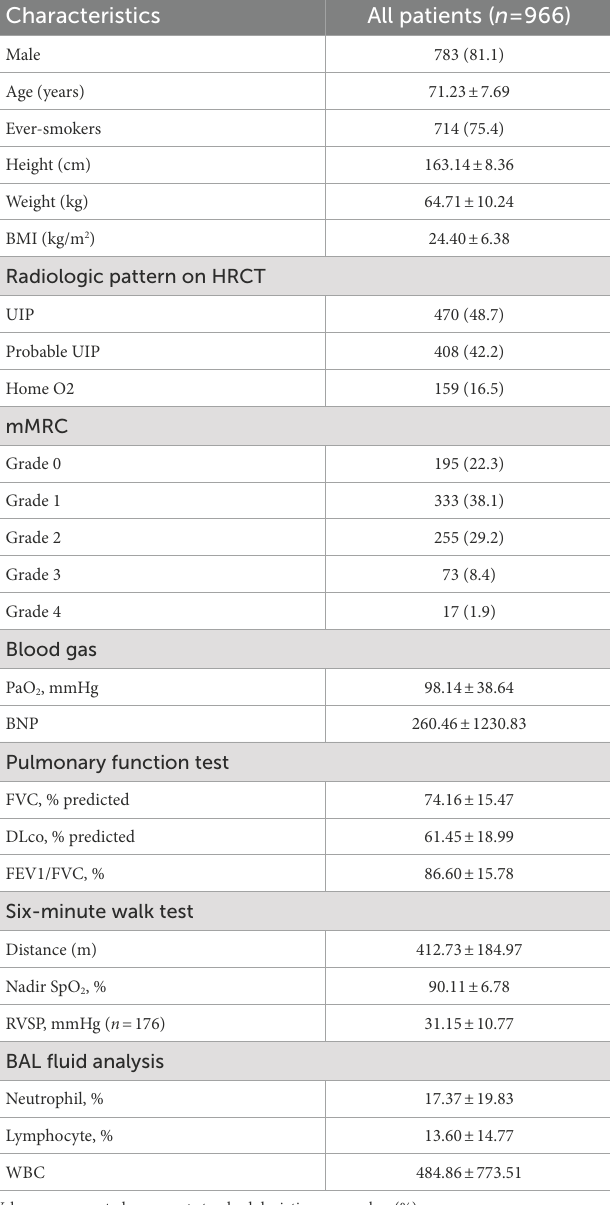
TABLE 2 Gender, age, and physiology (GAP) index and number (%) of